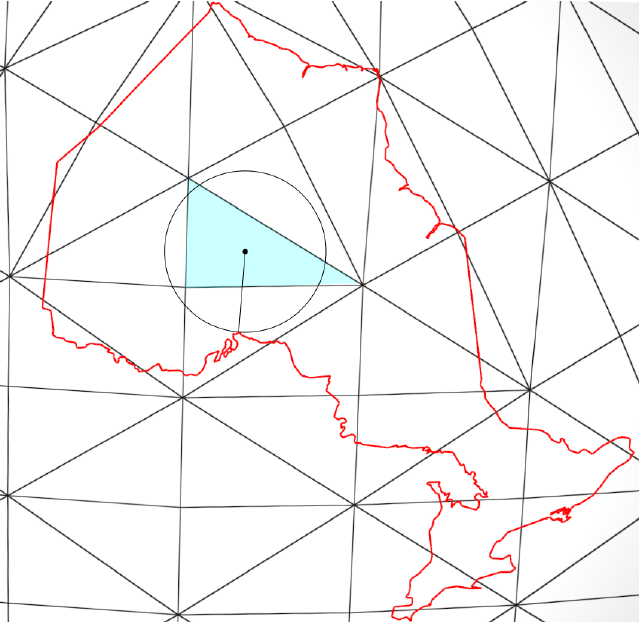
Figure 8. Distance of a cell to a